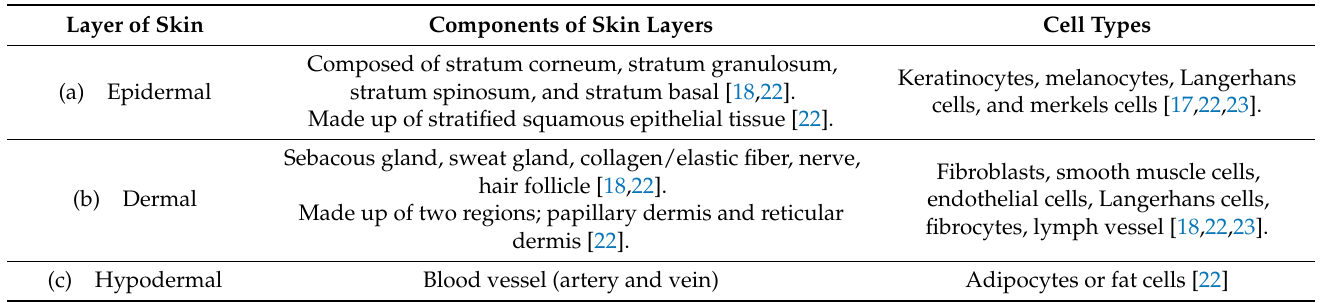
Table 1. The layers of the skin with multi components and cell